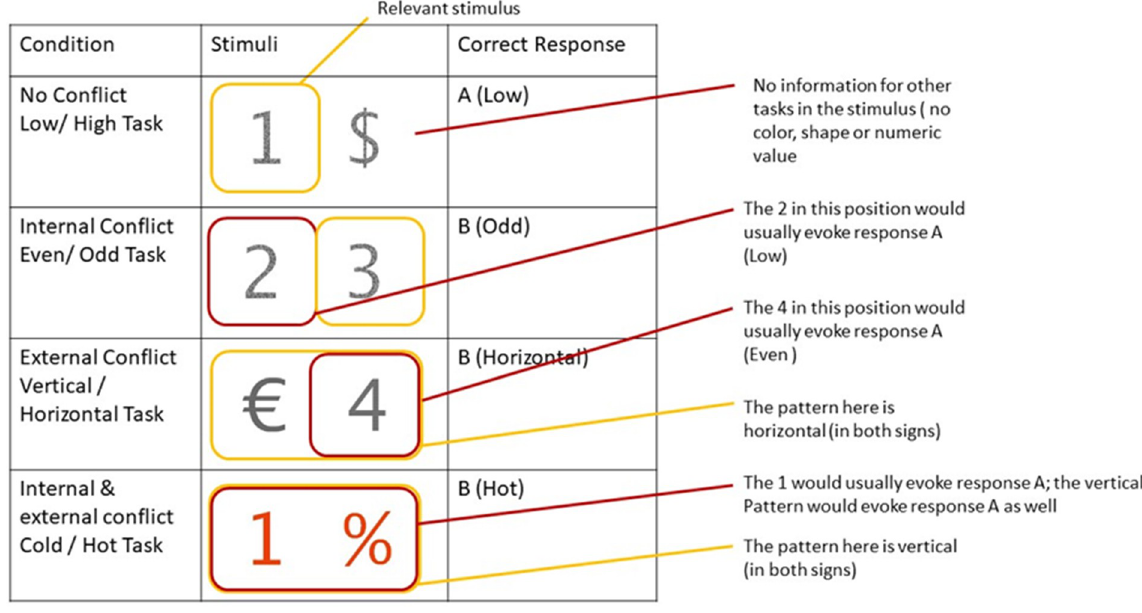
Fig 3. Examples of the different congruency